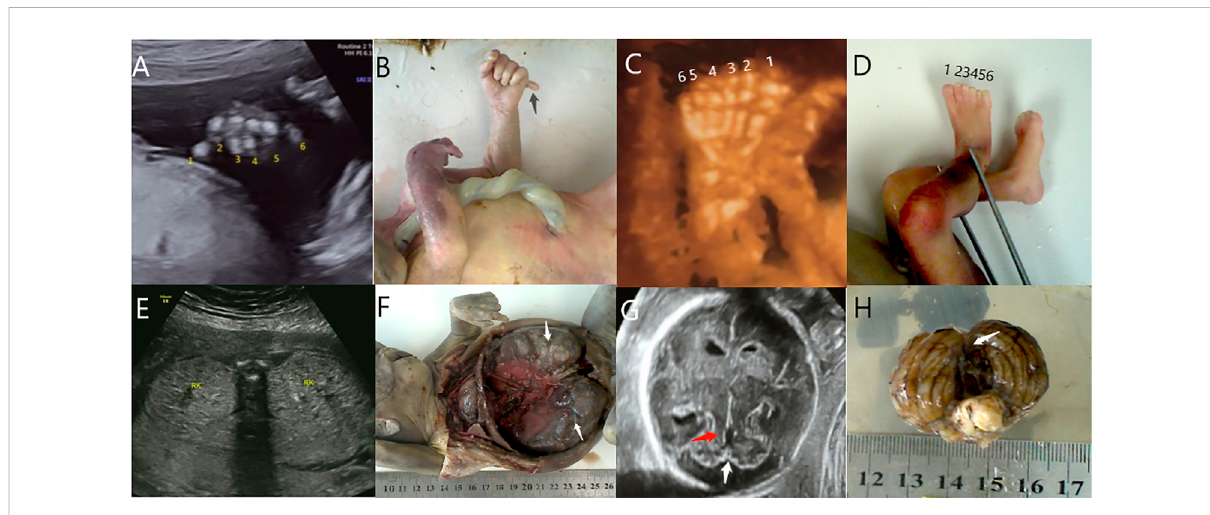
FIGURE 1 Polydactyly (black arrow) was detected by ultrasound (A) and autopsy (B) in case 1. Polydactyly was detected by ultrasound (C) and autopsy (D) in case 3. Polycystic kidneys (white arrow) were detected by ultrasound (E) and autopsy (F) in case 8. (G) The mild MTS (red arrow) and CV absence (white arrow) were detected by ultrasound in case 9. (H) CV absence (white arrow) was detected by an autopsy in case